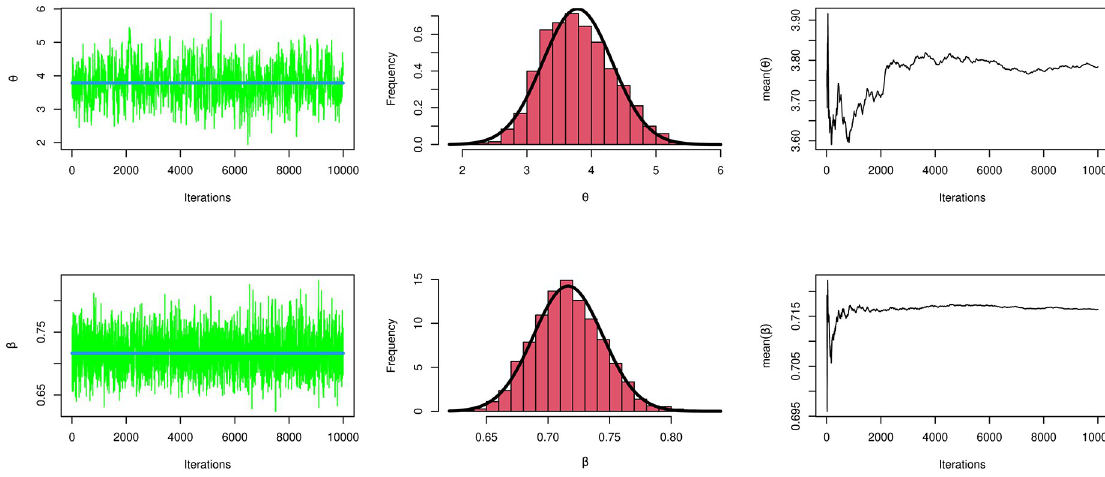
Fig 4. Convergence plots of MCMC for parameter estimates of MKTL distribution for the data under investigation.